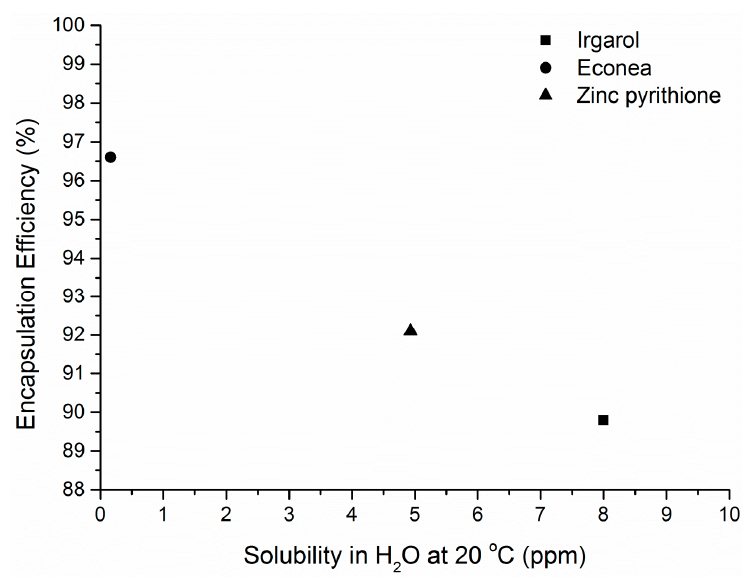
Figure 2. Correlation of encapsulation efficiency and solubility in water of the three tested biocides.